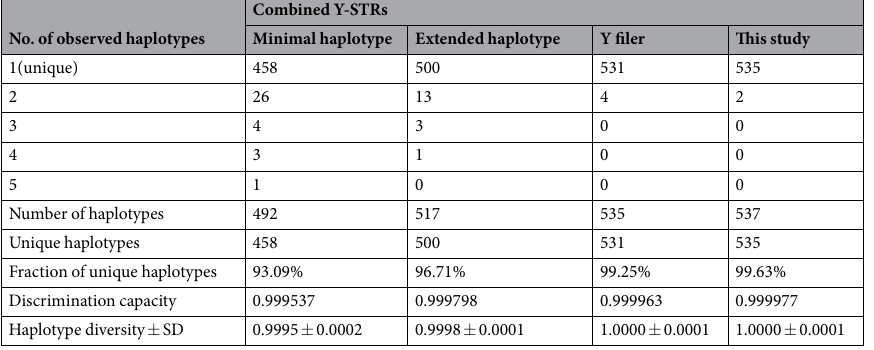
Table 1. Haplotype diversity and forensic parameters for different combinations of Y-STRs in 539 unrelated Northern Chinese Han.